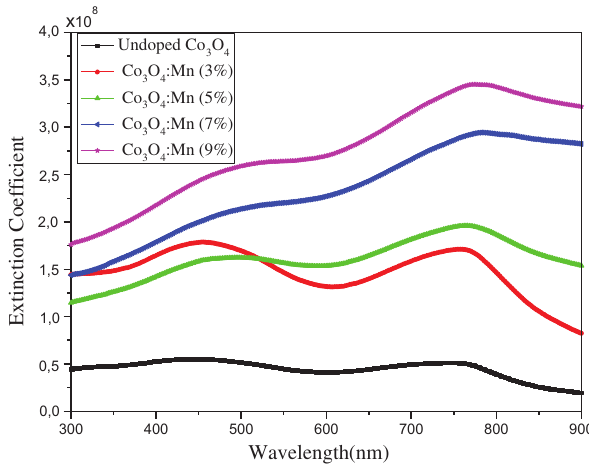
Figure 4: Extinction coefficient plots of Mn-doped Co 3 O 4